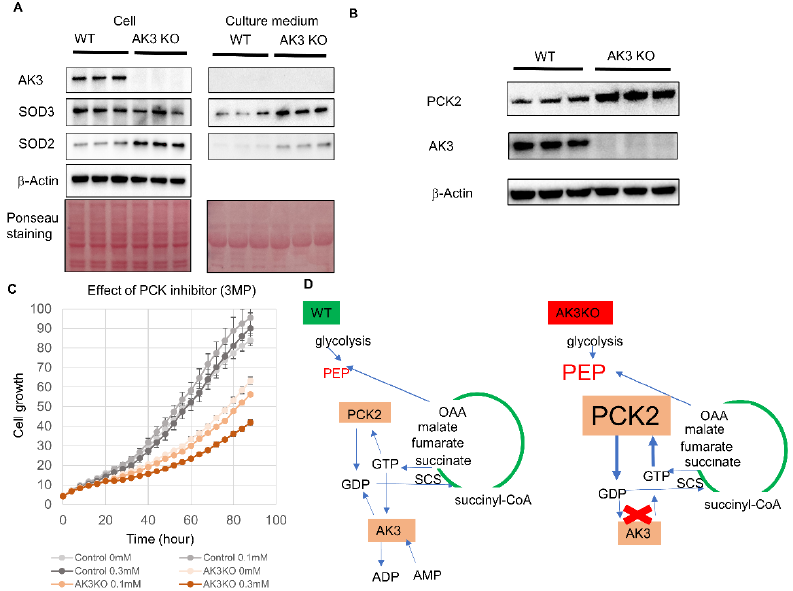
Figure 6. Evaluation of changes in protein expression in adenylate kinase 3 knockout (AK3KO) cells and effect of phosphoenolpyruvate carboxykinase 2 (PCK2) inhibition on AK3KO HeLa cell proliferation. ( A ) Evaluation of intracellular and extracellular protein expression using Western blotting. ( B ) Expression of PCK2 protein in AK3KO cells. ( C ) Effect of PCK2 inhibitor 3MP on proliferation of AK3KO and control HeLa cells. ( D ) Functions of PCK2 and AK3 in wild-type HeLa (HeLaWT) (left) and AK3KO (right) cells. In WT, AK3 and PCK2 produce GDP from GTP, but in AK3KO, PCK2 expression increases to complement reaction producing GDP from GTP.